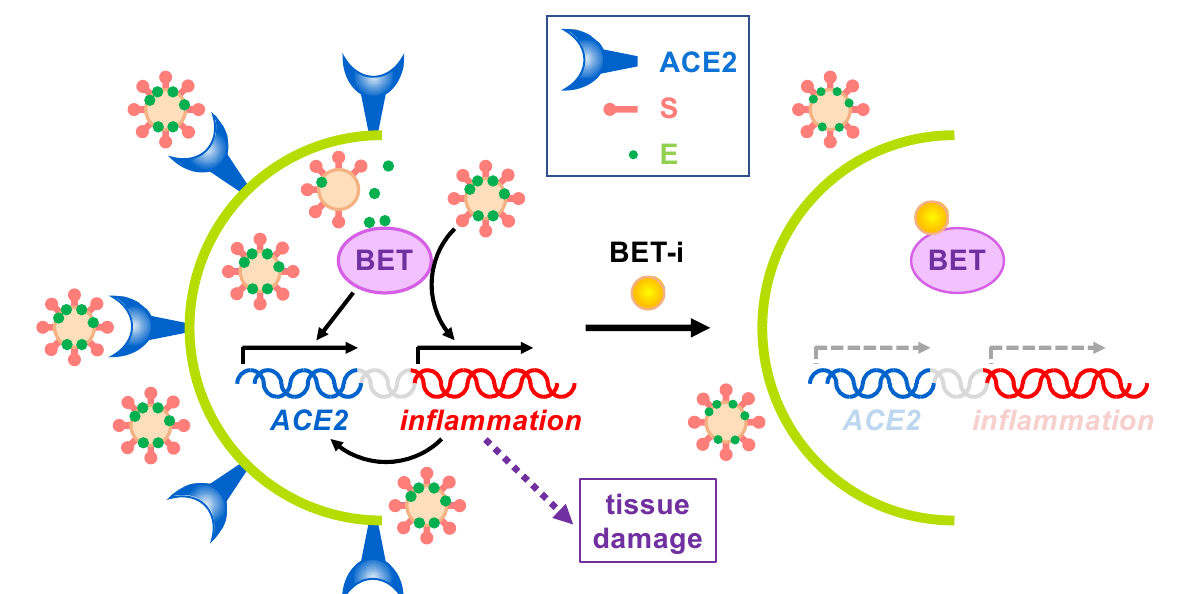
Figure 3. Effects of BET inhibition on SARS-CoV-2 infection. On one hand, expression of the SARS-CoV-2 receptor ACE2 depends on BET proteins. On the other hand, virus infection triggers the immune response, leading to BET-dependent activation of inflammation, which in turn may also activate ACE2 expression. Uncontrolled inflammation may cause severe tissue damage. Besides, SARS-CoV-2 E protein interacts with BETs, but no associated effects have been reported to date. The use of BET inhibitors (BET-i) attenuates ACE2 expression and counteracts inflammation, thus, reducing infection and tissue damage.